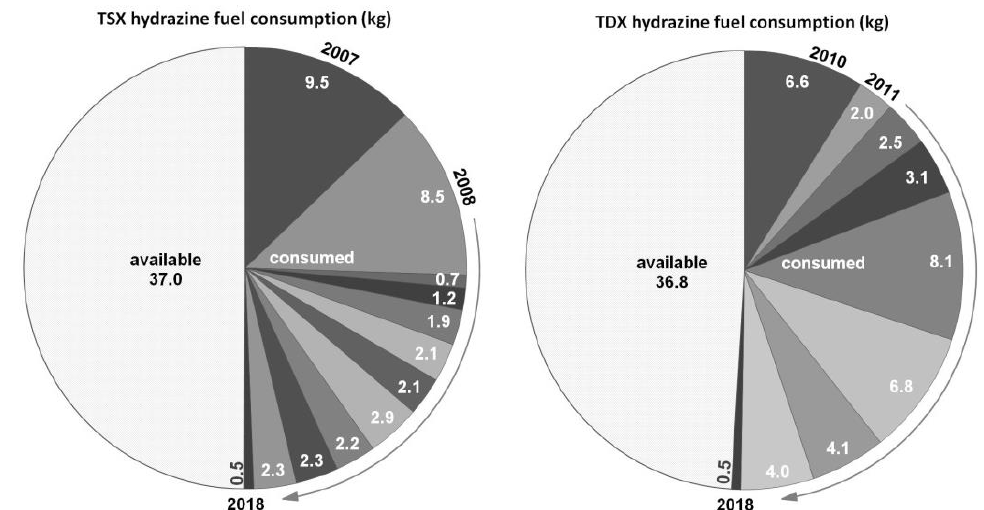
Figure 13. Pie charts of TSX and TDX in orbit hydrazine consumptions. Each slice in the “consumed” region represents an operations year for which the consumed fuel is reported. Approximately half of the hydrazine is still available for both satellites, see region “available”.